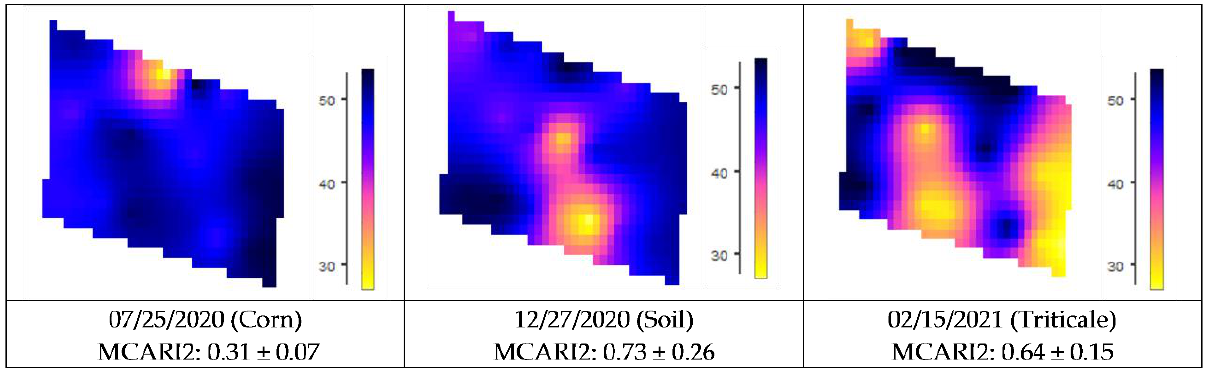
Figure 5. Example of soil water content (%) distribution map for three representative dates with average and standard deviation of MCARI2 index.